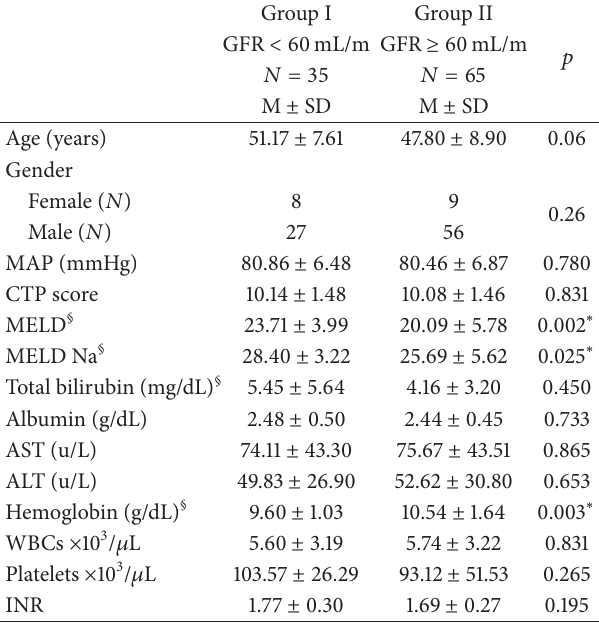
Table 1: Comparison of the baseline data in both groups. Table 2: Comparison of the renal function parameters in both groups.